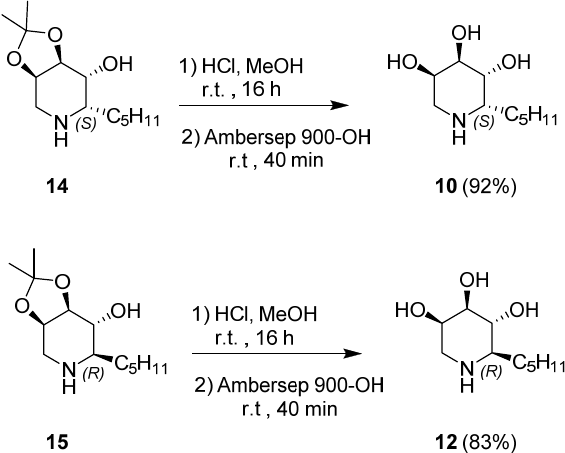
Figure 2. The two possible chair conformations of piperidines 14 and 15 . Dihedral angles between bonds analysed for the determination of the preferred conformation are shown in blue. Red double- ended arrows show the observed diagnostic NOE correlation peaks in the 1D-NOESY NMR spectra. 1 H-NMR chemical shifts of selected signals are reported, with the corresponding coupling constants in parenthesis (in Hz).